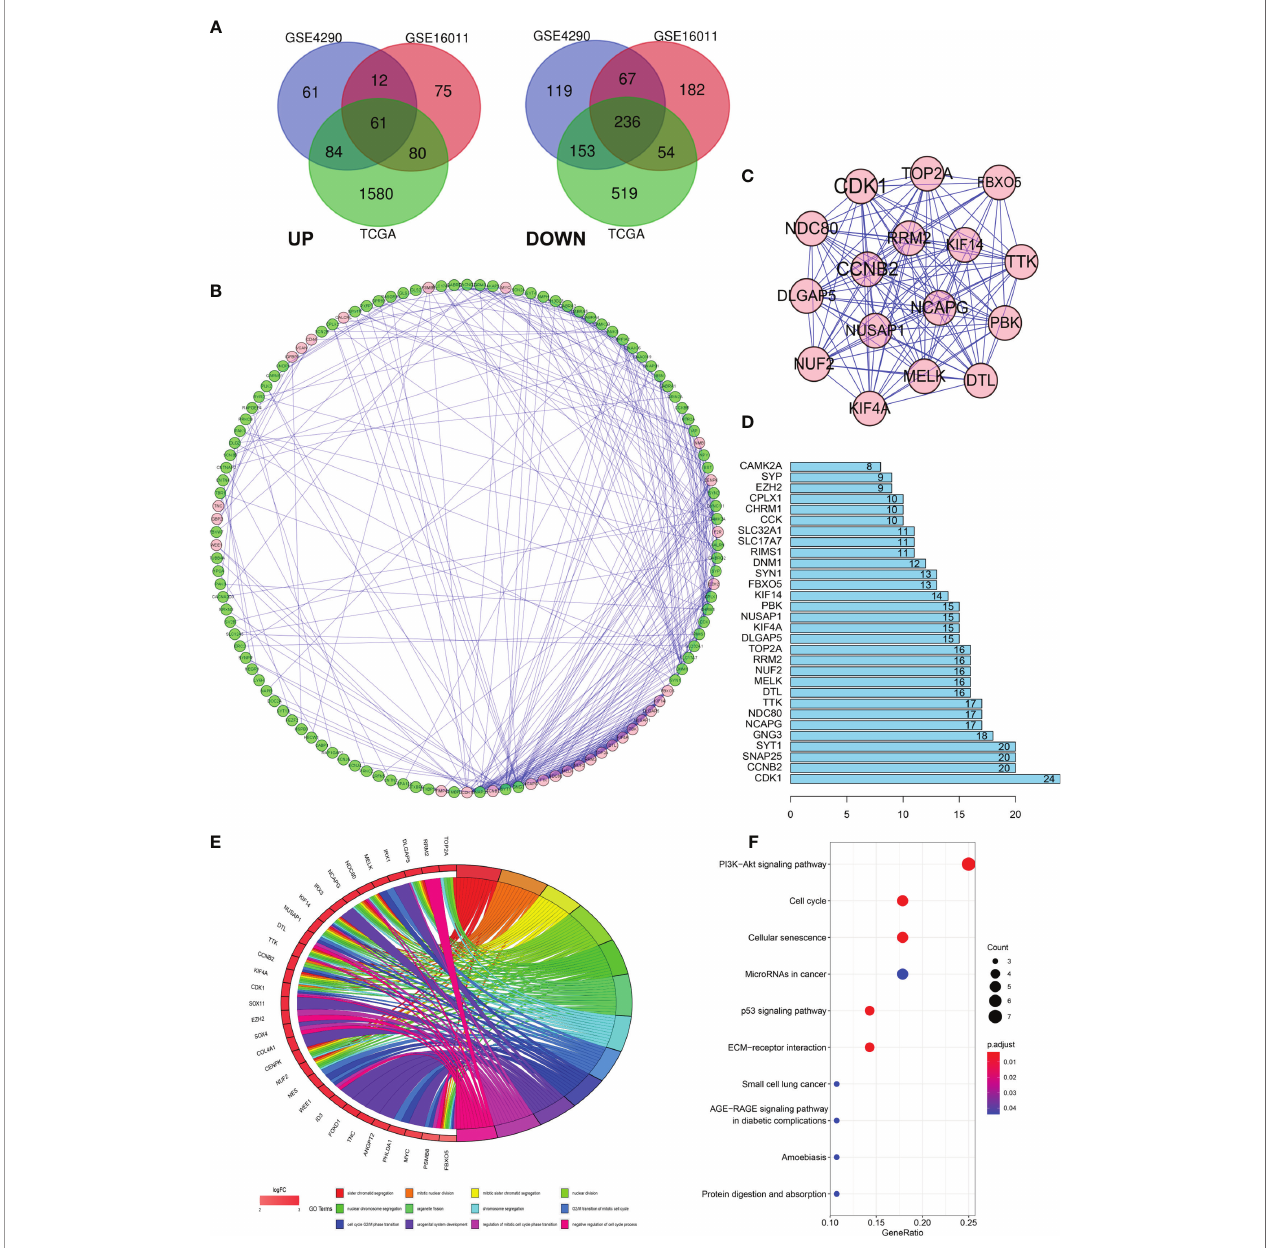
FIGURE 1 | Differentially expressed genes (DEGs) in glioma and the functional analysis of DEGs. (A) Venn diagram of DEGs based on TCGA and GEO. (B – D) Protein – protein interaction (PPI) of DEGs. (E, F) Gene ontology (GO) and pathway enrichment analysis of the glioma enriched